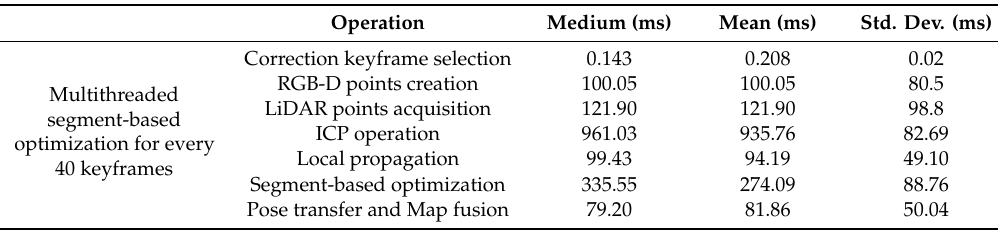
Table 11. Average optimization time per keyframe in LiDAR correction thread.